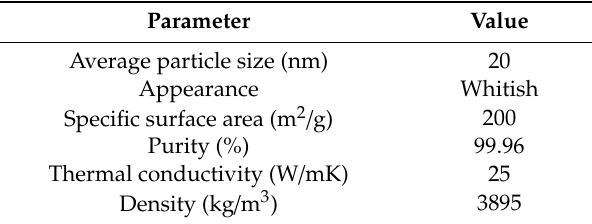
Table 1. Characteristic features of Al 2 O 3 nanoparticles.